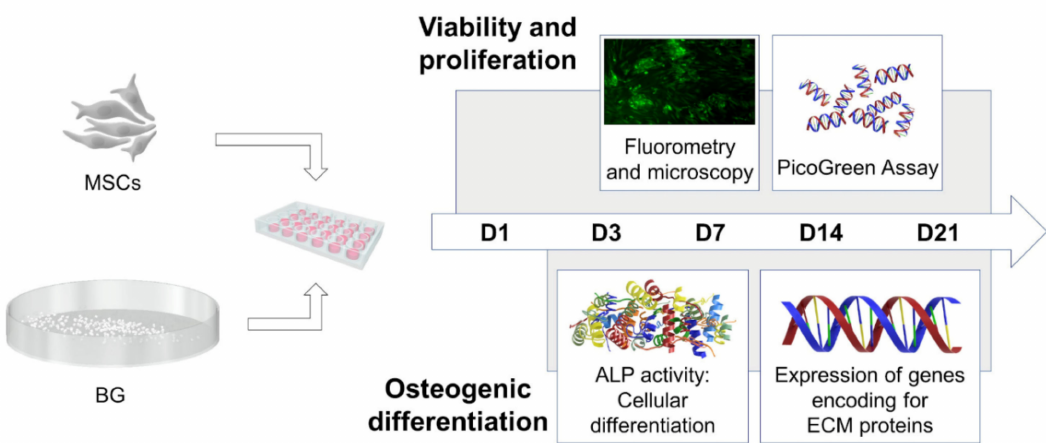
Figure 6. Overview of the experimental design. Mesenchymal stromal cells (MSCs) were co-cultured with bioactive glass (BG) granules for a total incubation period of 21 days (D). On D1, D3, D7, D14 and D21 cell viability was analyzed quantitatively as well as qualitatively and cell proliferation was assessed. In addition, alkaline phosphatase (ALP) activity and expression of genes encoding for extracellular matrix (ECM) proteins were evaluated starting from D3 after